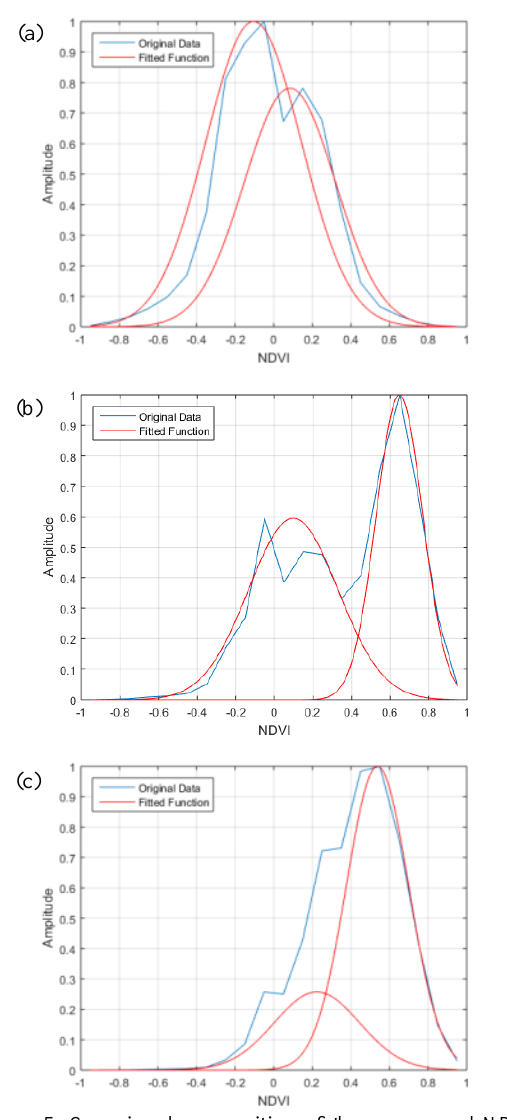
Figure 5. Gaussian decomposition of the non-ground NDVIs’ histograms; a) NDVI C2-C1 , b) NDVI C2-C3 , and c) NDVI